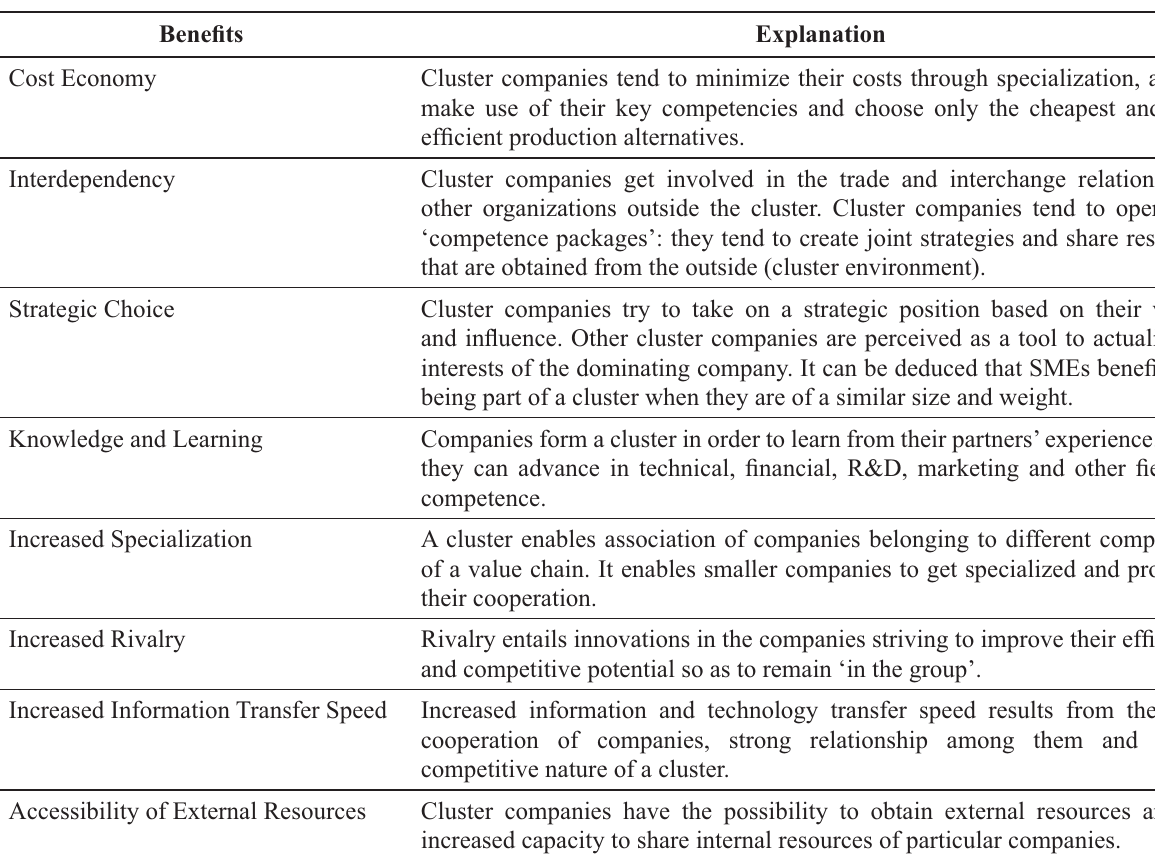
Table. The Benefi ts of Clusterization to SMEs Benefi